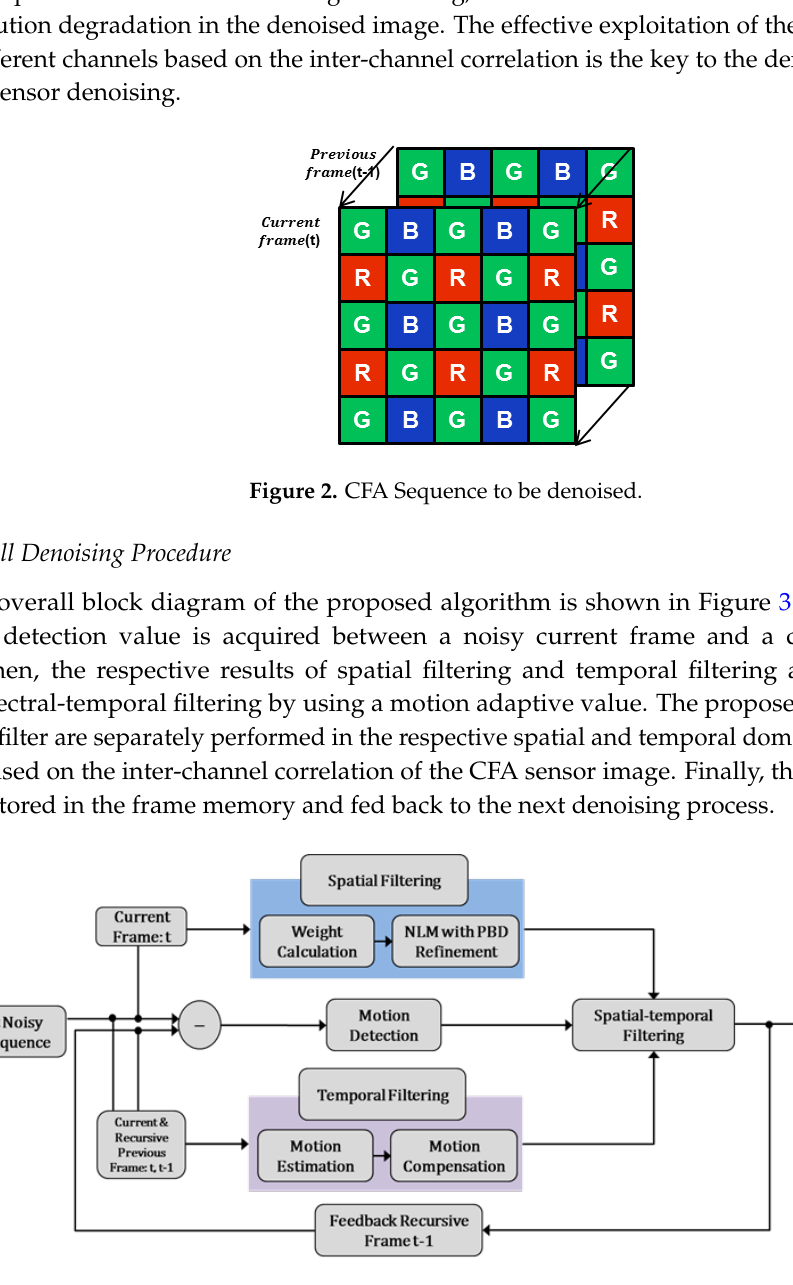
Figure 3. Block diagram of the proposed denoising algorithm.